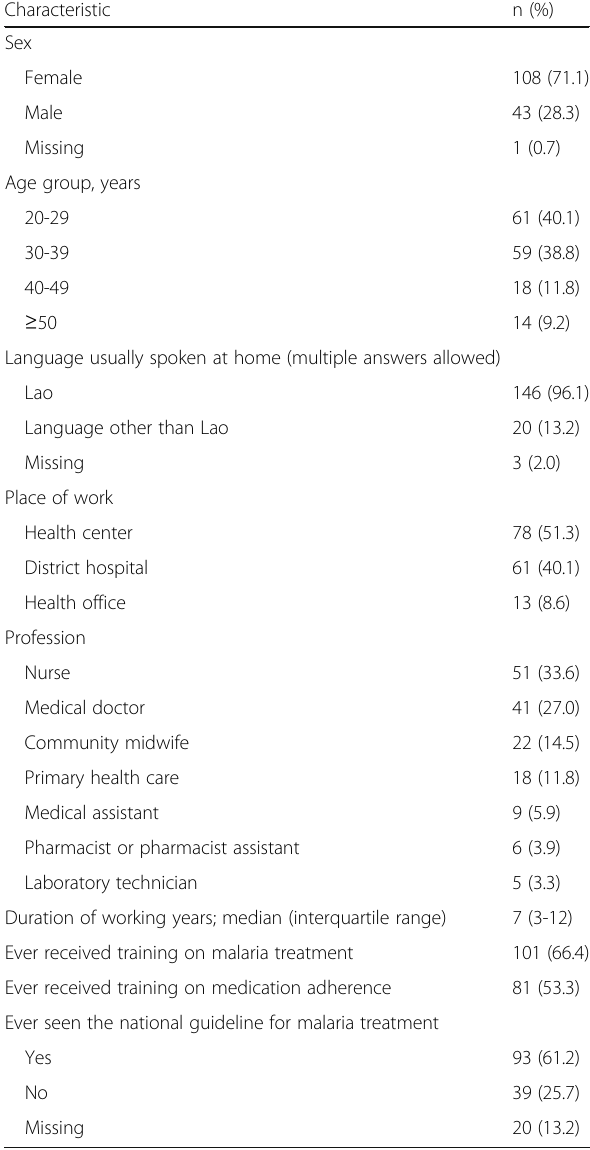
Table 4 Characteristics of the healthcare workers (n=152)